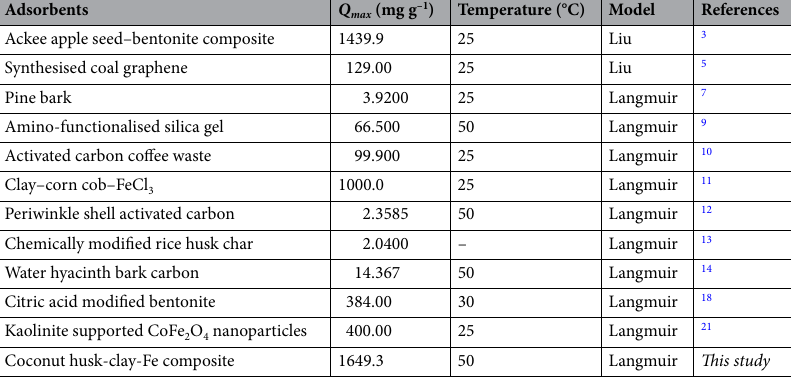
Table 4. Comparison of CHCFe with other adsorbents for adsorption of Congo red.